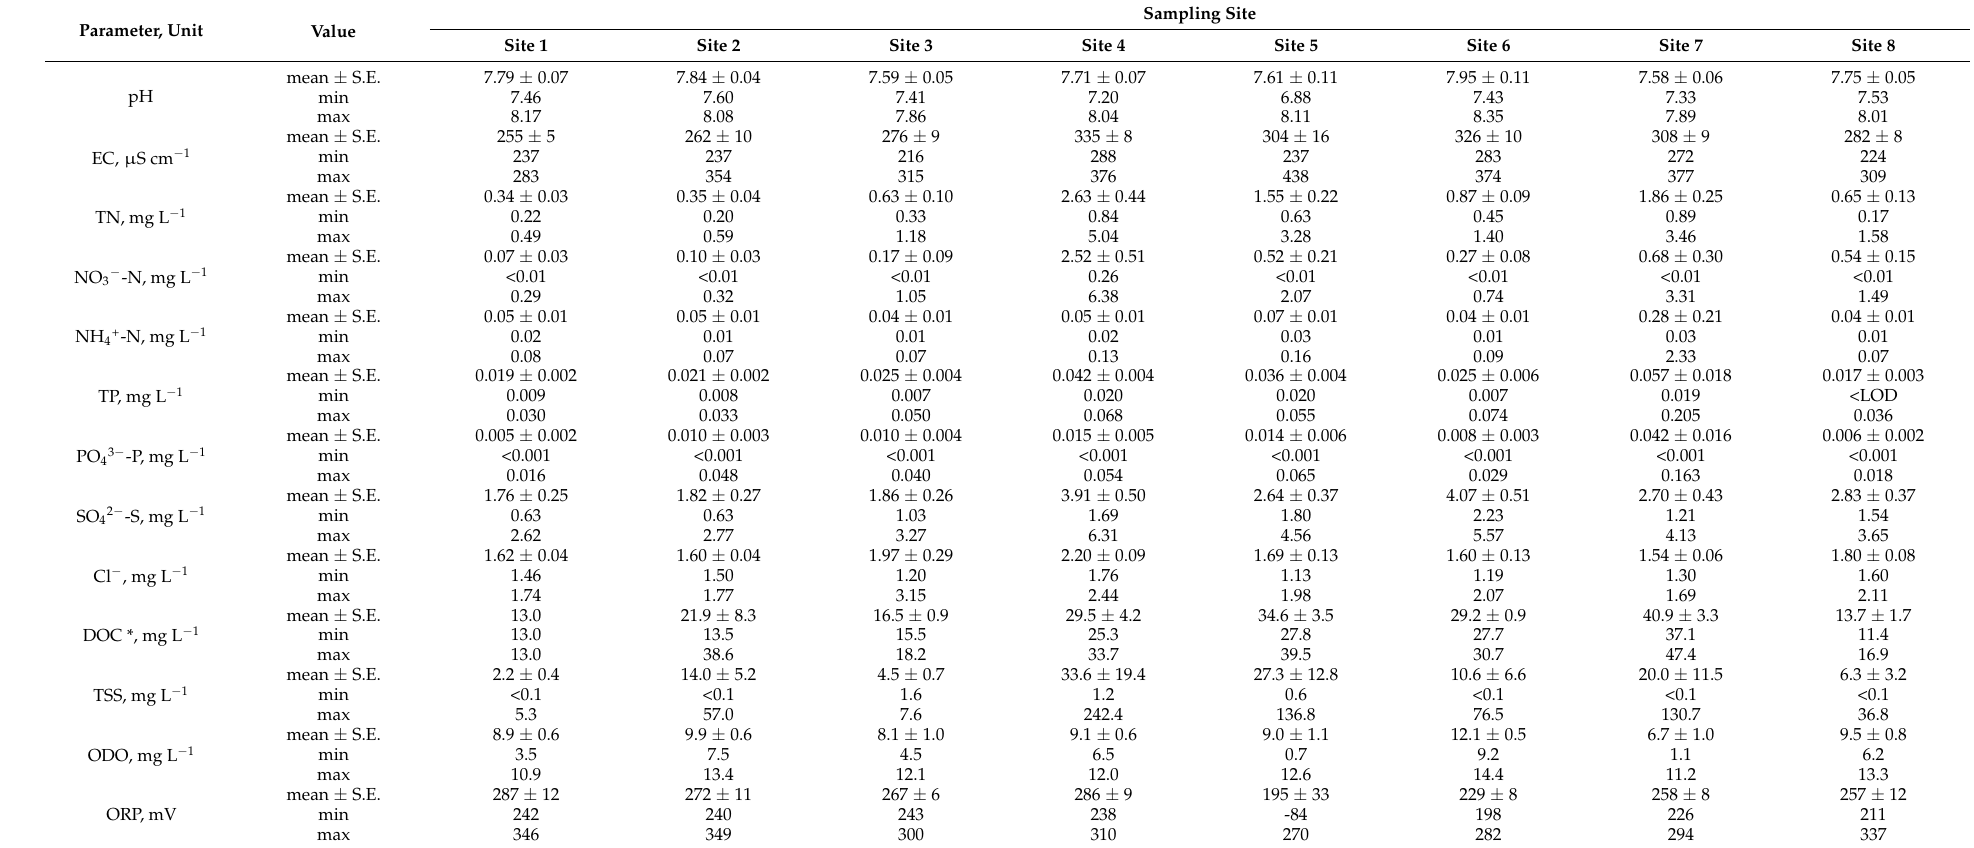
Table A2. General water chemistry in small watercourses of drainage systems on forest land with organic soils by sampling site. Annual mean ± S.E., minimum and maximum values are shown in the